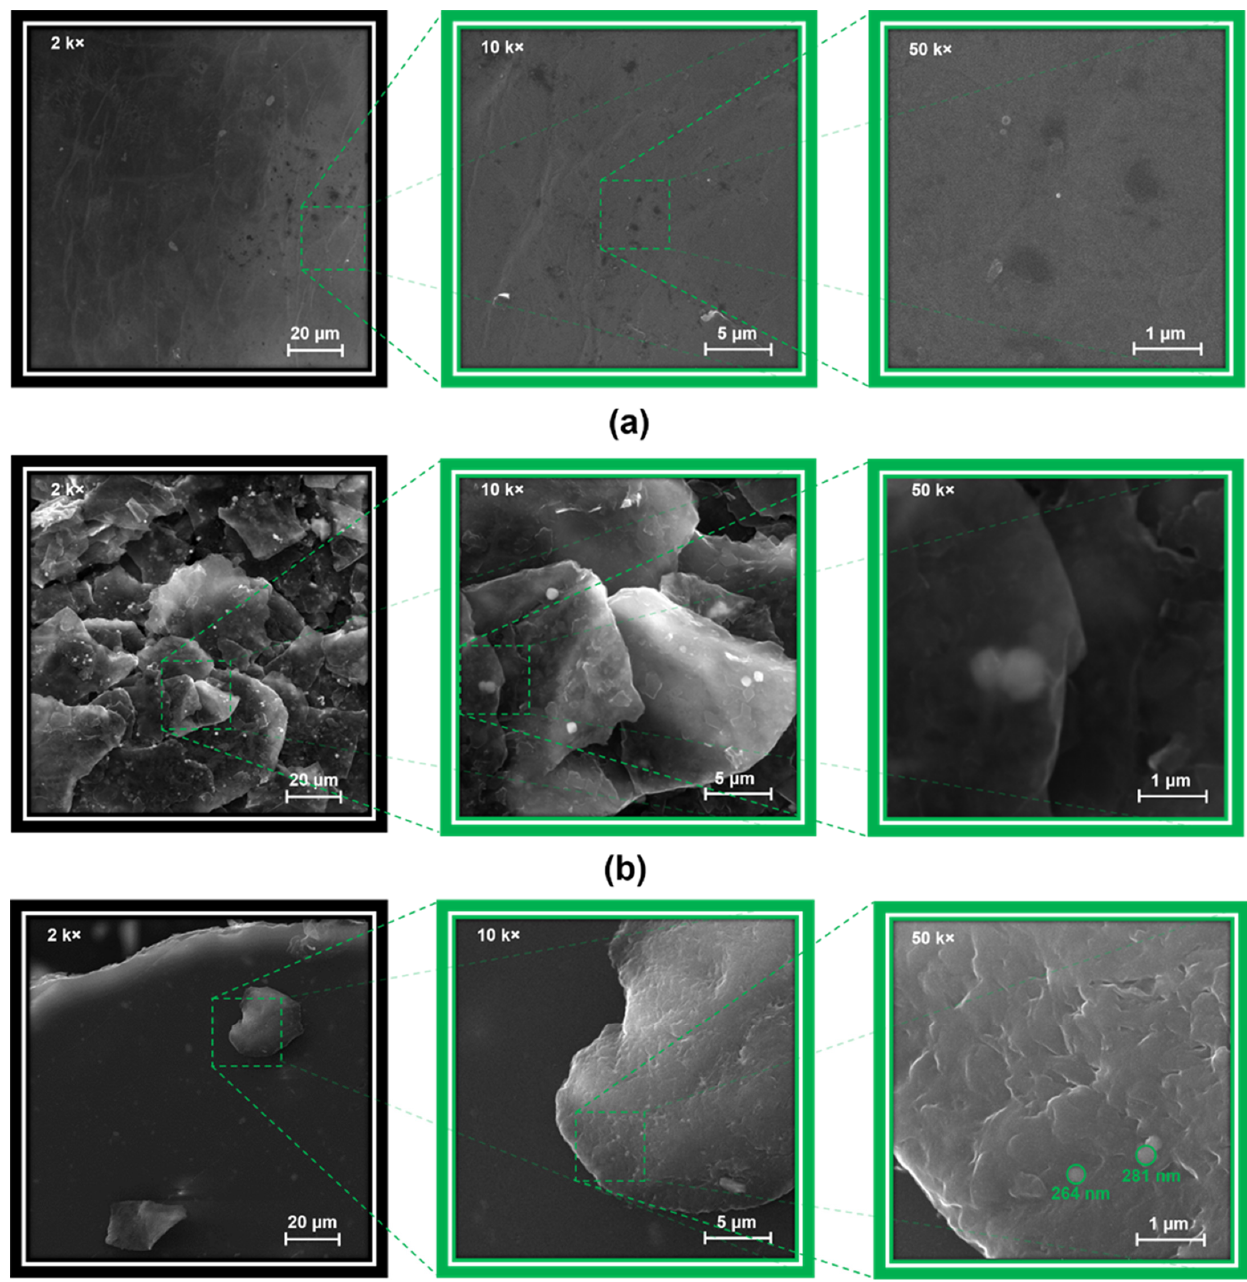
Figure 1. SEM micrographs of the initial GO ( a ), surface modified UV-rGO flakes ( b ) and a film surface for PS/UV- rGO@TMSPM composite ( c ) taken at 2 k×, 10 k× and 50 k× magnifications. Table 1. EDX analysis data of graphene oxide components for organic-inorganic